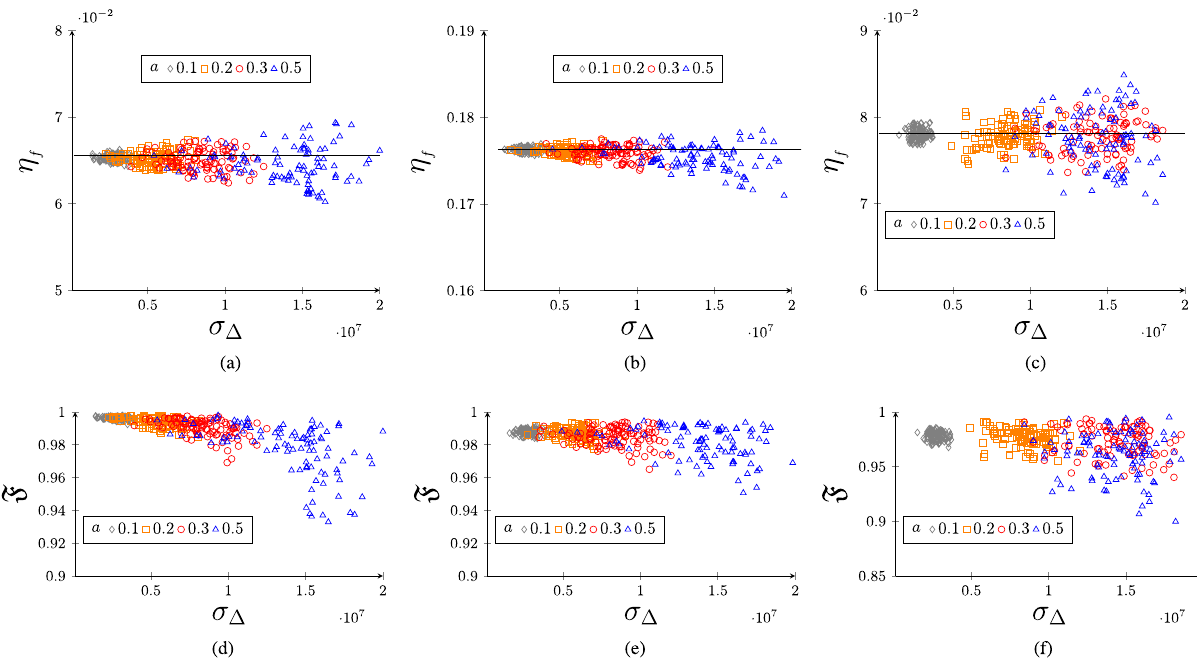
Figure 3. In ( a , b ) we plot the efficiency for non-uniform comb with no fluctuations in the tooth-spacing. Here the non-uniformity is quantified by the standard deviation σ � of mean frequency of each of the tooth in the frequency comb. We have set F represents efficiency for the uniform comb. In ( c ) we plot efficiency of Cesium atom I-AFC at magnetic field strength